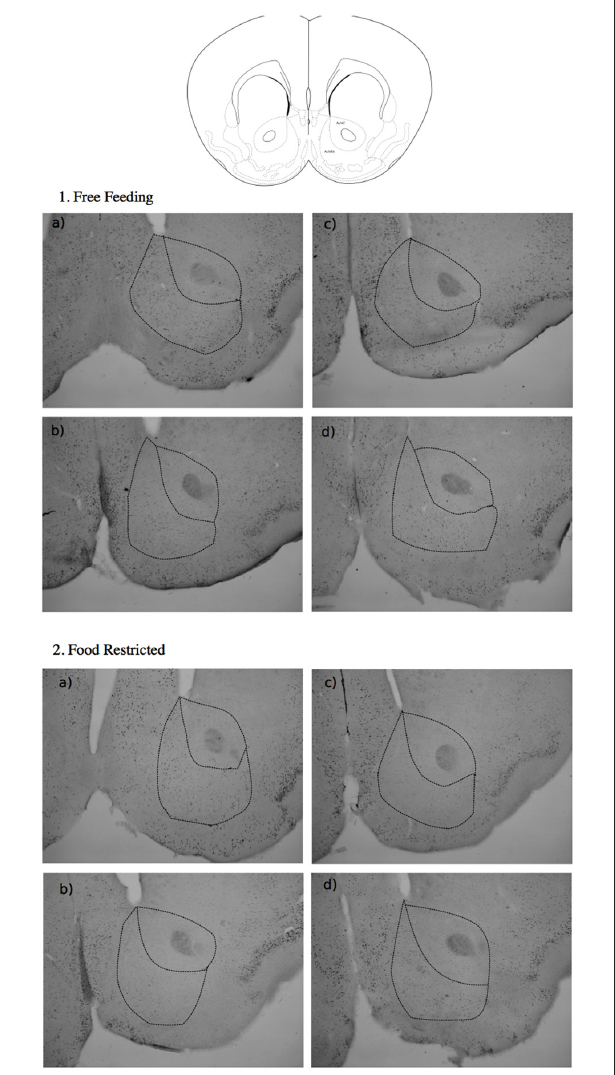
FIGURE 3 | Representative images of immunostained specimens from the NAc Core and Shell of free fed (FF, top) and food-restricted (FR, bottom) mice. (a) Sham-depleted mice exposed to MC, (b) sham-depleted mice exposed to OBJ, (c) NE-depleted exposed to MC, (d) NE-depleted exposed to OBJ.